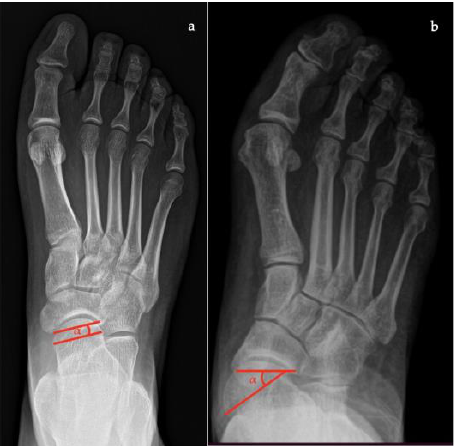
Figure 2. Talonavicular coverage angle (between the line that joins the medial and lateral articular margins of the talus, and the line between that joins the medial and lateral articular margins of the navicular). ( a ) Normal foot, 2°; ( b ) pathological flatfoot, 35°.